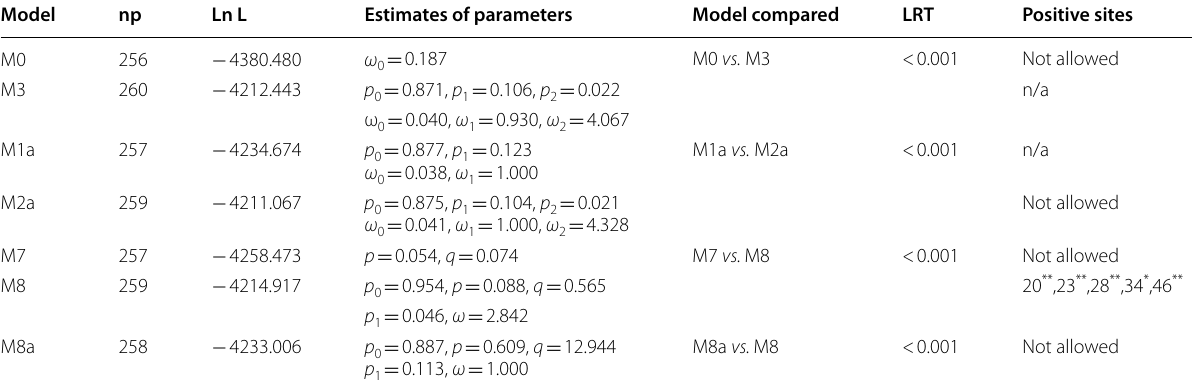
*Posterior probability > 0.95; **Posterior probability > 0.99%; ns, not significant; np, the numbers of parameters; Ln L, log-likelihood value; LRT: likelihood-ratio test; n/a, no data available